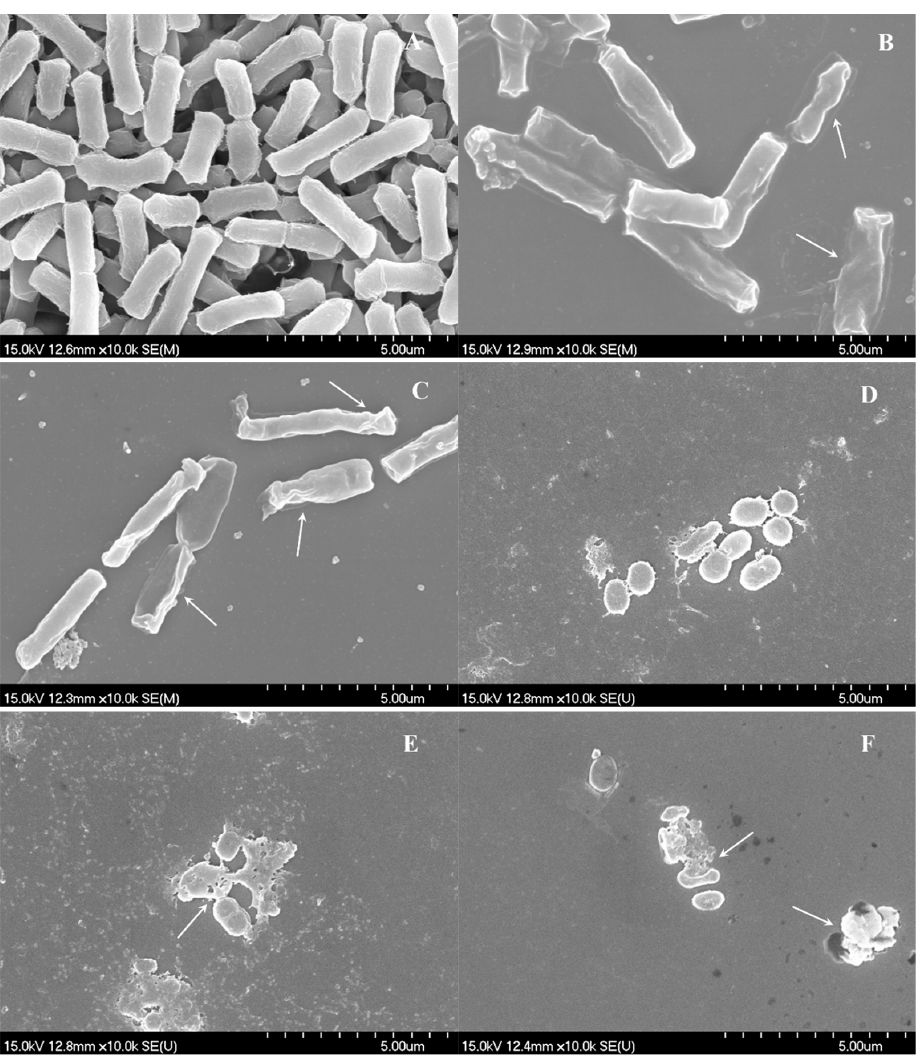
Figure 1. E ff ects of FCEO on morphological changes of E. coli and S. aureus . ( A ): Untreated E. coli ; ( B ): E. coli treated with FCEO at minimal inhibitory concentration (MIC); ( C ): E. coli treated with FCEO at 2 × MIC; ( D ): Untreated S. aureus ; ( E ): S. aureus treated with FCEO at MIC; ( F ): S. aureus treated with FCEO at 2 × MIC. Arrows show the shriveled appearance and holes on the cell